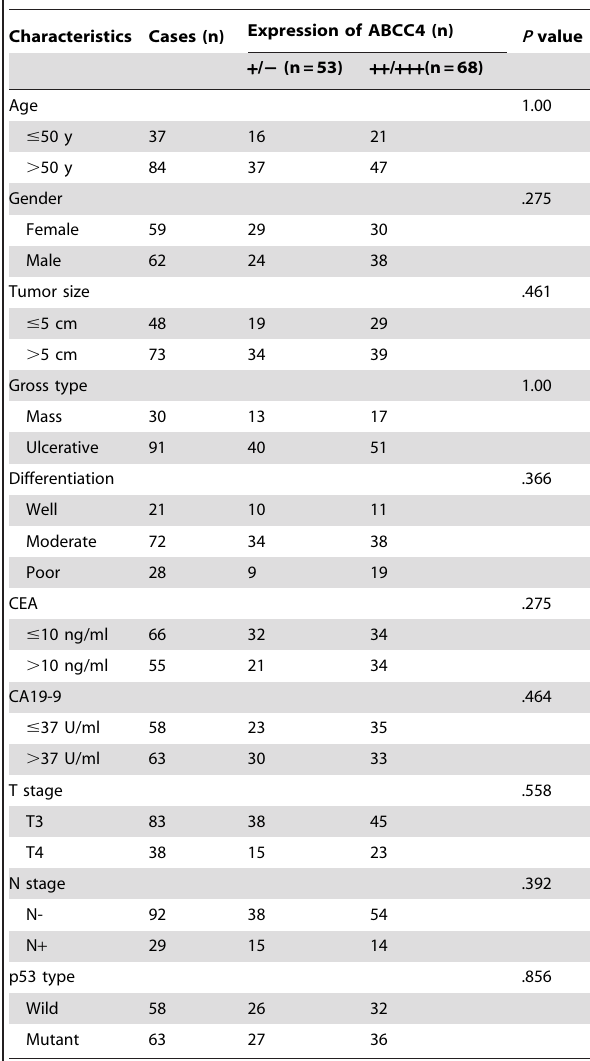
Table 1. Correlation of Clinicopathological Characteristics with ABCC4 Expression in 121 LARC Patients Treated with Preoperative nRT.